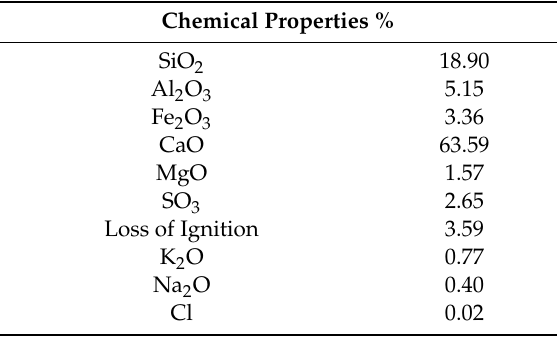
Table 1. CEM I 42.5 R cement chemical properties.